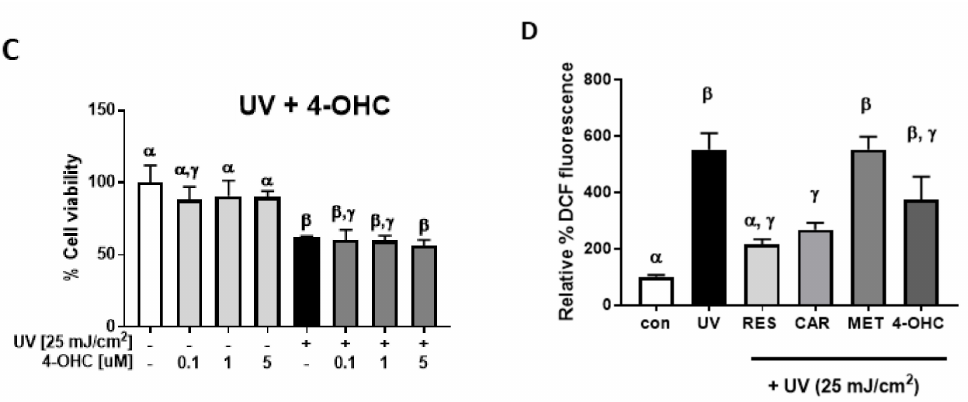
Figure 1. E ff ect of carvedilol, metoprolol, and 4-hydroxycarbazole (4-OHC) on ultraviolet (UV) radiation-induced reduction of cell viability and formation of reactive oxygen species (ROS) in JB6 P + cells. JB6 P + cells were treated with UV radiation at the dose of 25 mJ / cm 2 . After UV exposure, the cells were treated with the indicated concentrations of carvedilol (CAR) ( A ), metoprolol (MET) ( B ), or 4-OHC ( C ). After 24 h of incubation, the number of viable cells were counted using the Trypan blue exclusion assay. Data presented are the mean +/ − SD of 3~6 independent experiments. The number of viable cells was normalized as the percentage of vehicle control. ( D ) JB6 P + cells were treated with resveratrol (RES) (50 µ M, positive control), carvedilol, metoprolol, or 4-OHC (10 µ M each) for two hours and then loaded with PBS containing 10 µ M H2-DCF-DA for 30 min. The cells were then exposed to UV irradiation (25 mJ / cm 2 ) and incubated for 30 min. The DCF fluorescence levels were determined using flow cytometry. Each bar represents the mean +/ − SE ( n = 3). The bars with a di ff erent letter are significantly di ff erent from each other at the level of P <